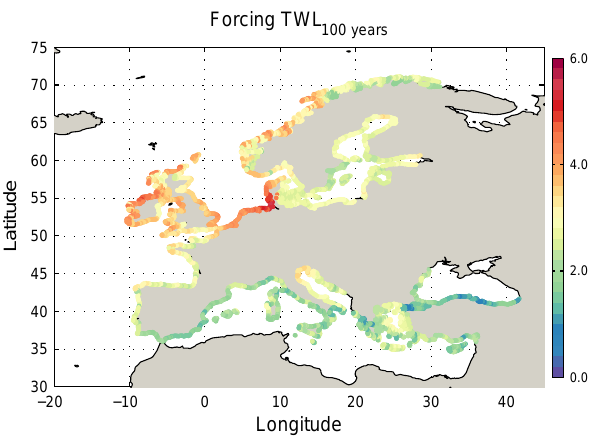
Figure 1. Total water level values for the present-day 100-year event along the European coastline; values are shown every 25km of